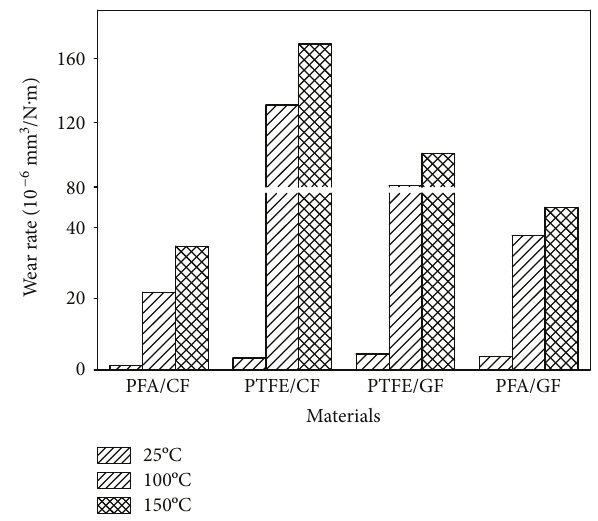
Figure 4: Wear rates of the PTFE and PFA composites at di ff erent